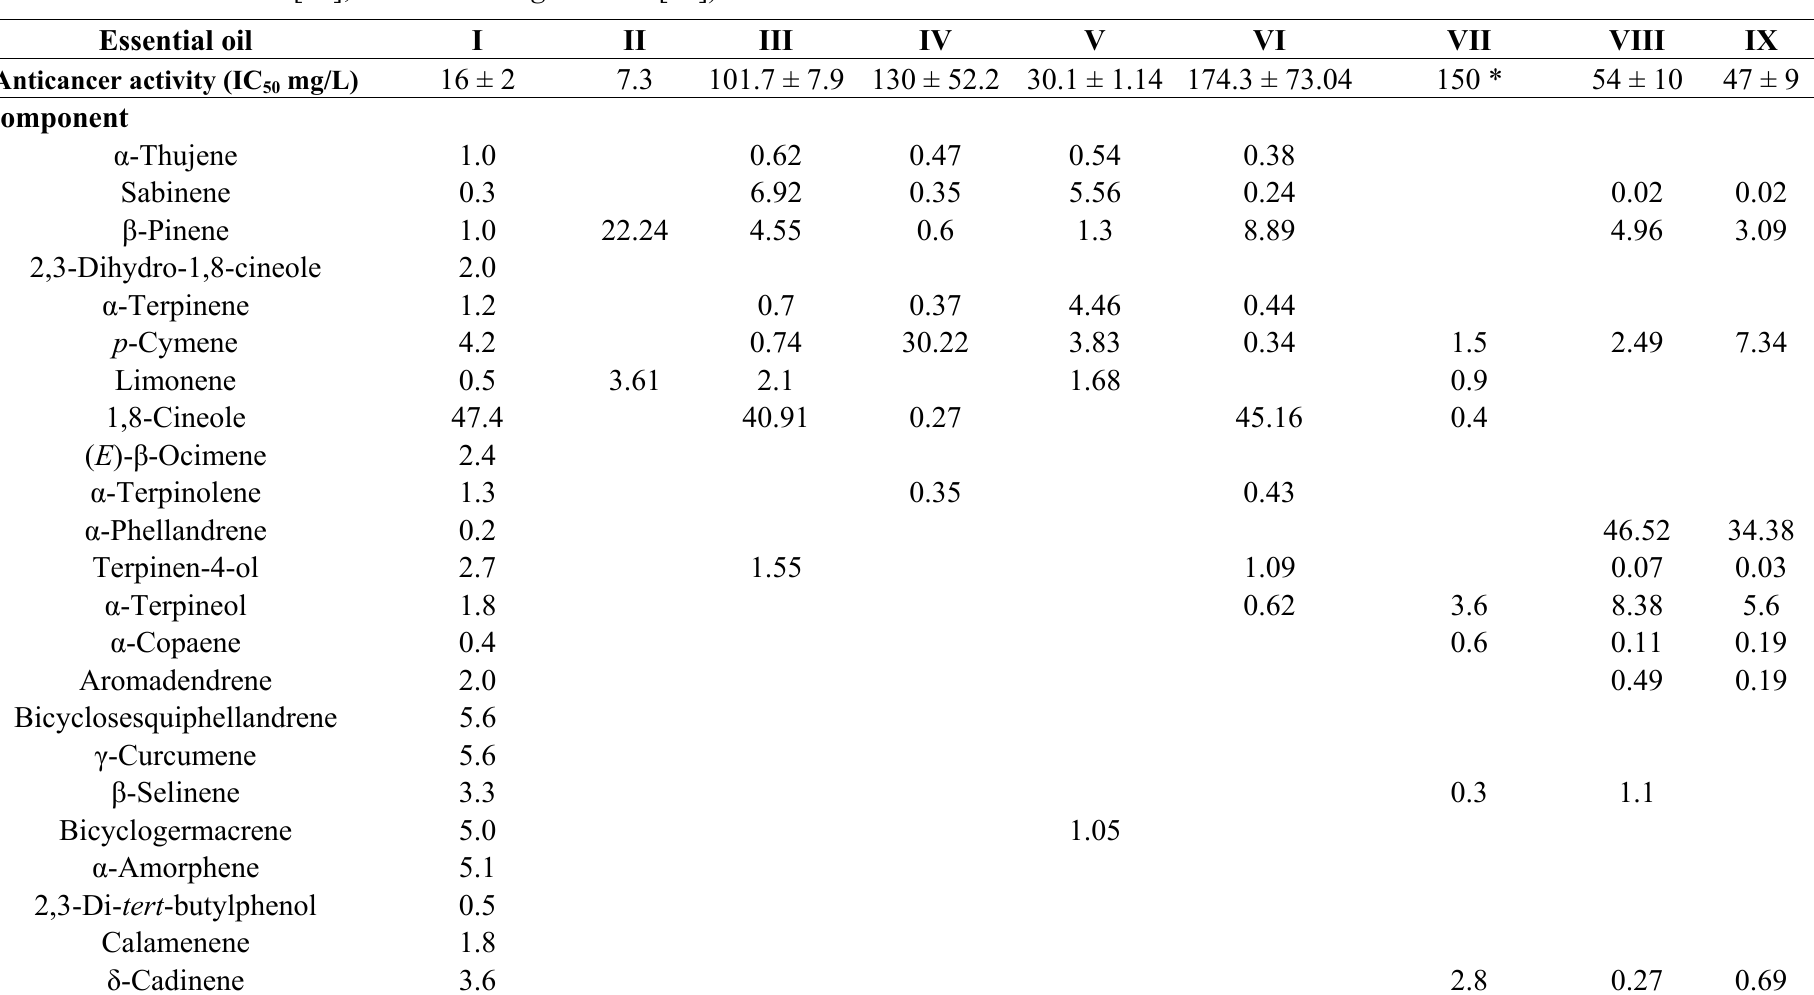
Table 3. Anticancer activity and chemical composition of essential oils (I: Helichrysum gymnocephalum ; II: Schefflera heptaphylla [30]; III: Laurus nobilis ; IV: Origanum syriacum ; V: Origanum vulgare ; VI: Salvia triloba [31]; VII: Heteropyxis dehniae [32]; VIII: Schinus molle ; IX: Schinus terebenthifolius [33]; X: Salvia officinalis [34]; XI: Melaleuca alternifolia [35]; XII: Citrus limon ; XIII: Citrus medica